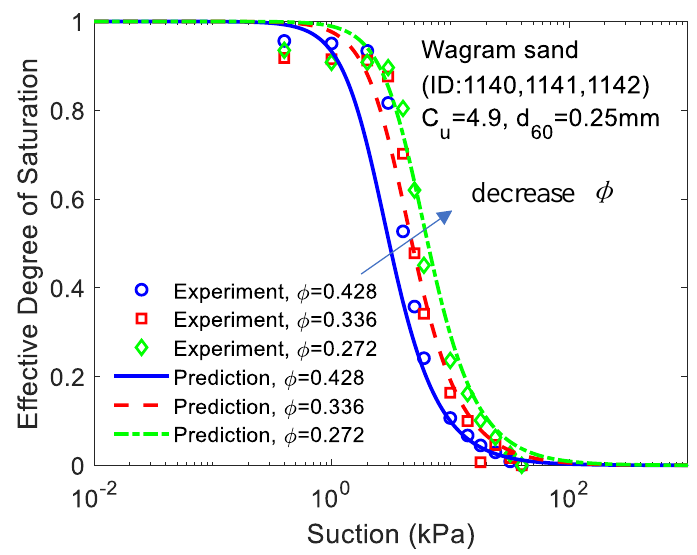
Figure 6. Measured and predicted water retention behaviour of the Wagram sand.